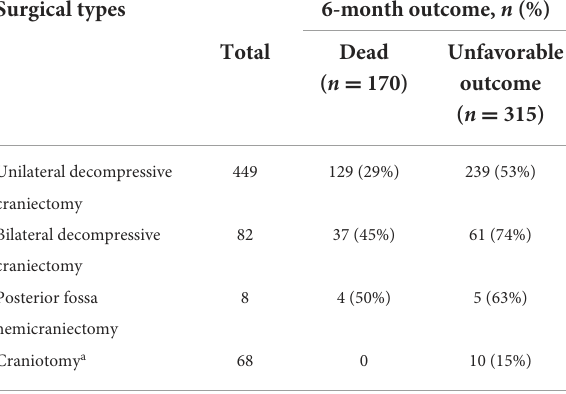
explanation for outcome in PLANC cohort. Surgical